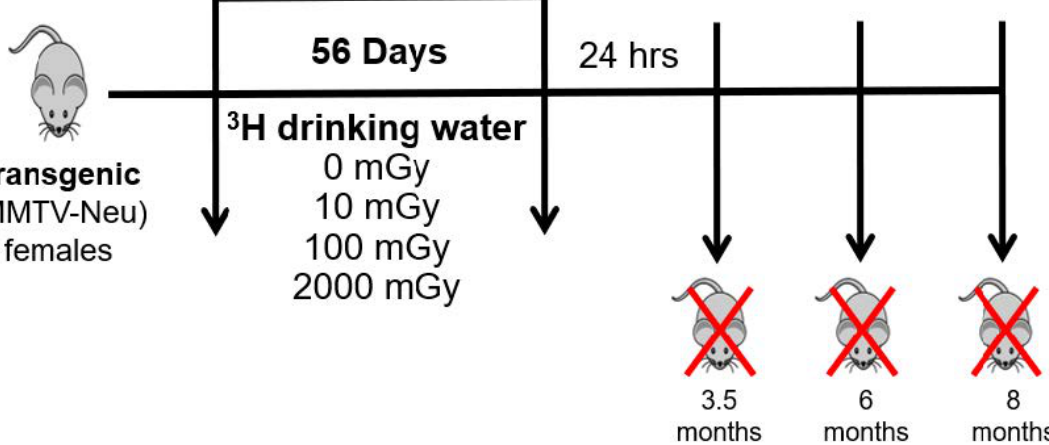
Figure 1. Schematic diagram of the study. Transgenic “MMTV-Neu” female mice underwent chronic low-dose tritium exposure (via drinking water), starting at 1.5 months of age, to a total dose of 0, 10, 100, and 2000 mGy over 56 days. Mice were sacrificed at three time-points: 3.5, 6, and 8 months of age. Blood, spleen, lungs and mammary glands were collected for further processing and analysis. Tumor number and volume were assessed in tumor-bearing mice at the time of sacrifice.